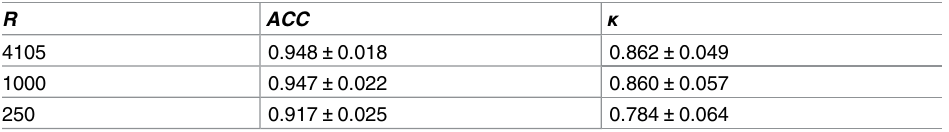
Table 2. Accuracy of NRAD-basedclassification.